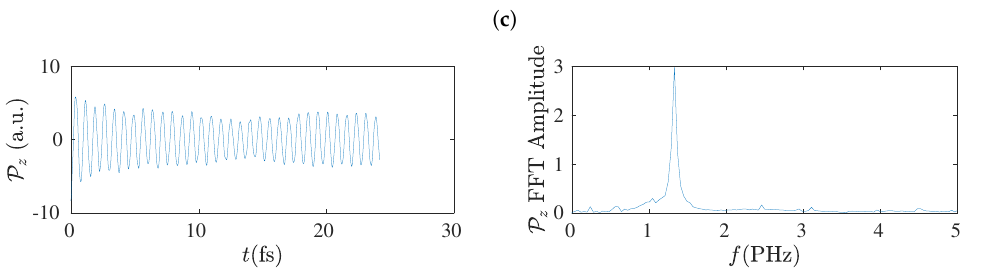
Figure 18. Left column: Dipole moment oscillations along the z -axis, P z , obtained by RT-TDDFT at the B3LYP/cc-pVTZ level of theory, for N = 8, for cumulenic ( cu ) molecules with coplanar ( co ) methylene groups as well as for polyynic ( po ) molecules starting with short ( sl ) or long ( ls ) bonds. Right column: The corresponding FFT amplitudes obtained by MATLAB without any further elaboration. ( a ) cu co , ( b ) po sl , ( c ) po ls .